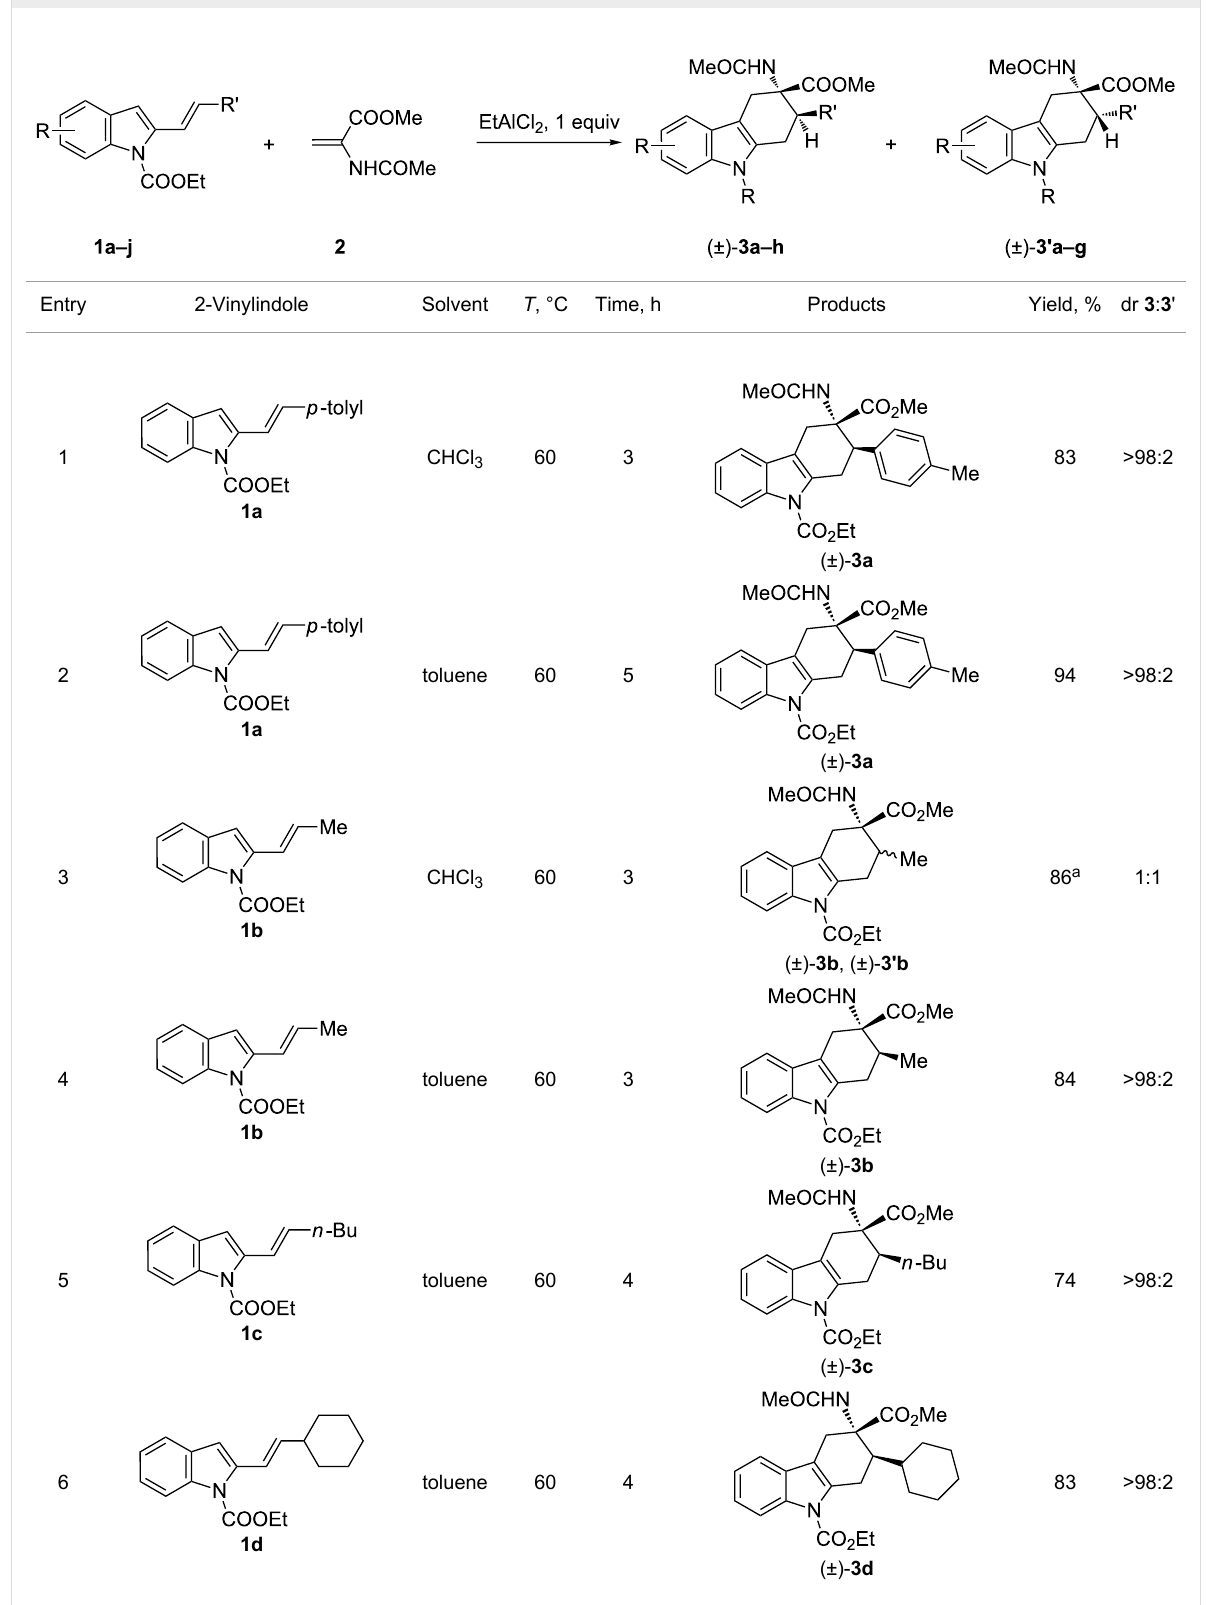
Table 2: Scope of the cycloaddition reactions between 2-vinylindoles 1a–j and methyl 2-acetamidoacrylate ( 2